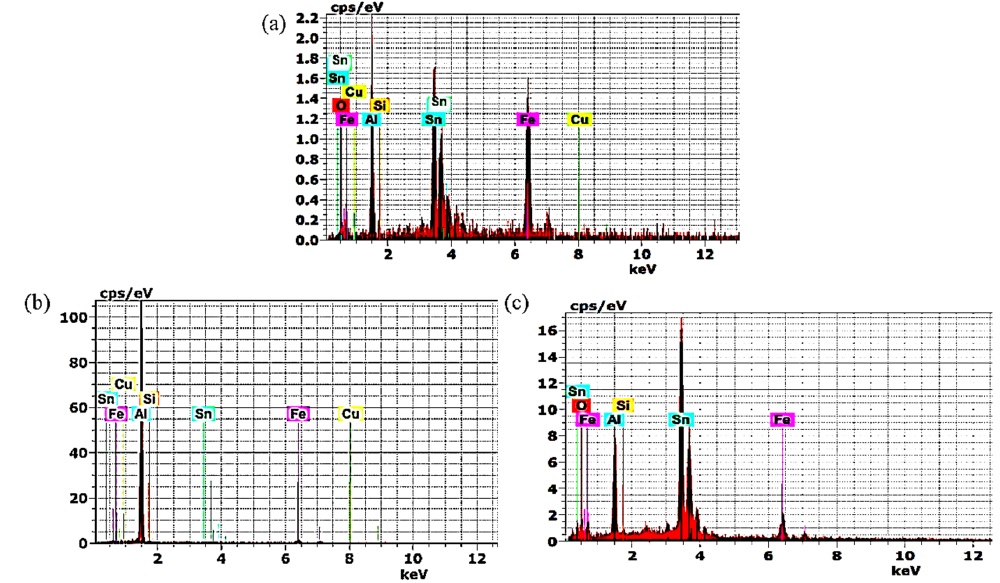
Figure 6. EDS patterns in interface layers adjacent to Al bearing alloy zones in bimetallic castings containing tin-to-flux ratio of ( a ) 1: 5, ( b ) 1:10, and ( c ) and 1:15 at points 1, 2 and 3 shown in Figure 5a–c, respectively. Table 2. EDS analysis corresponding to the points 1, 2 and 3 indicated in Figure 5.